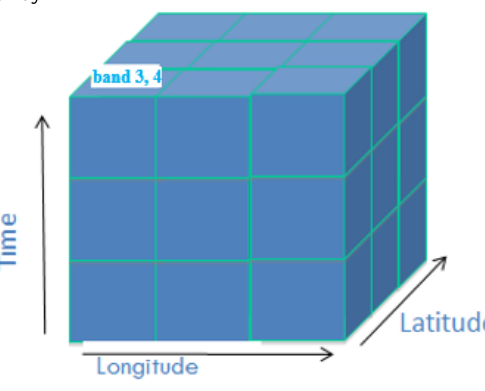
Figure 1. Image Storage as SciDB Array After that, the repart operator in AFL was used to restructure data in chunk size of 60*60*256. It means each chunk stores complete time series of 60 rows and 60 columns. To run change monitoring using the r_exec plugin it is necessary